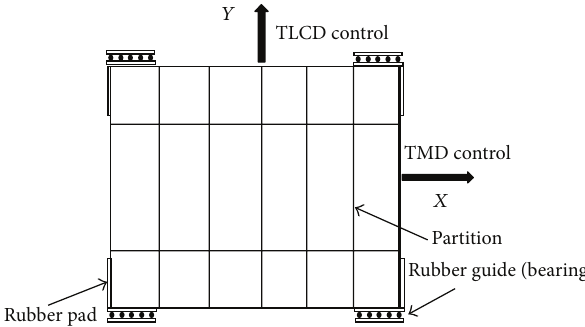
Figure 10: The tuned liquid mass damper.